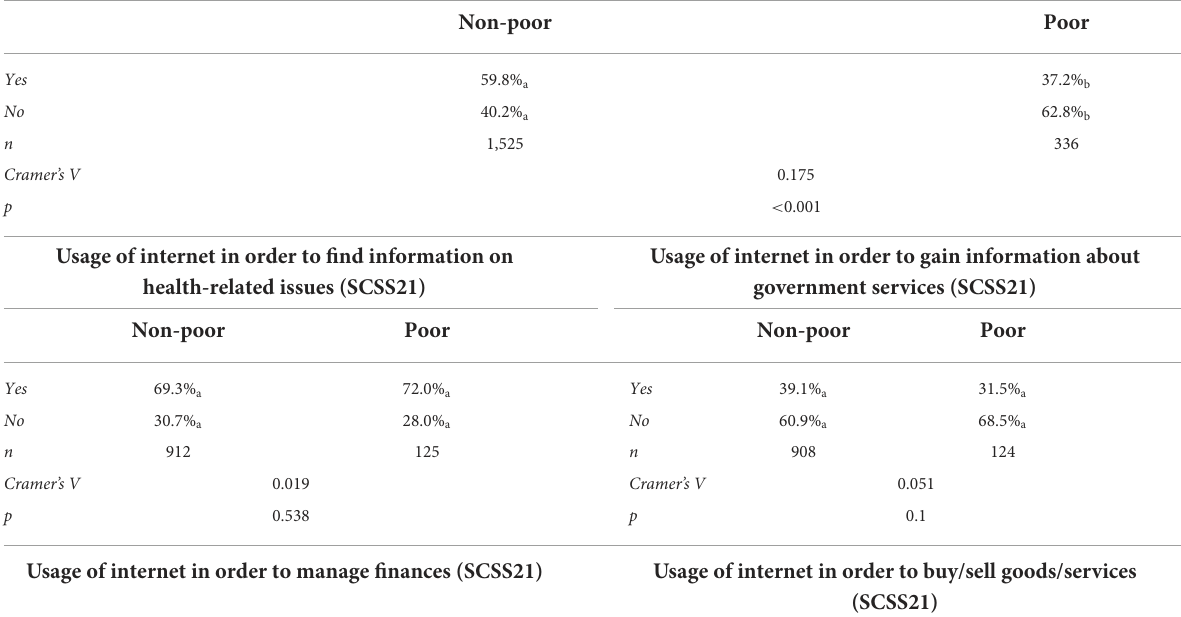
Usage of internet since the outbreak